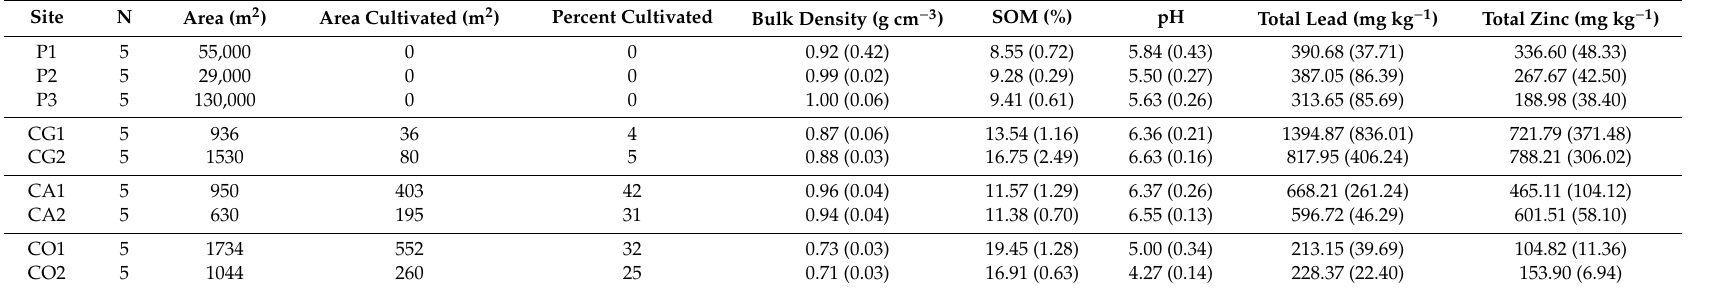
Table 1. Soil characteristics by site mean ( ± S.E.).